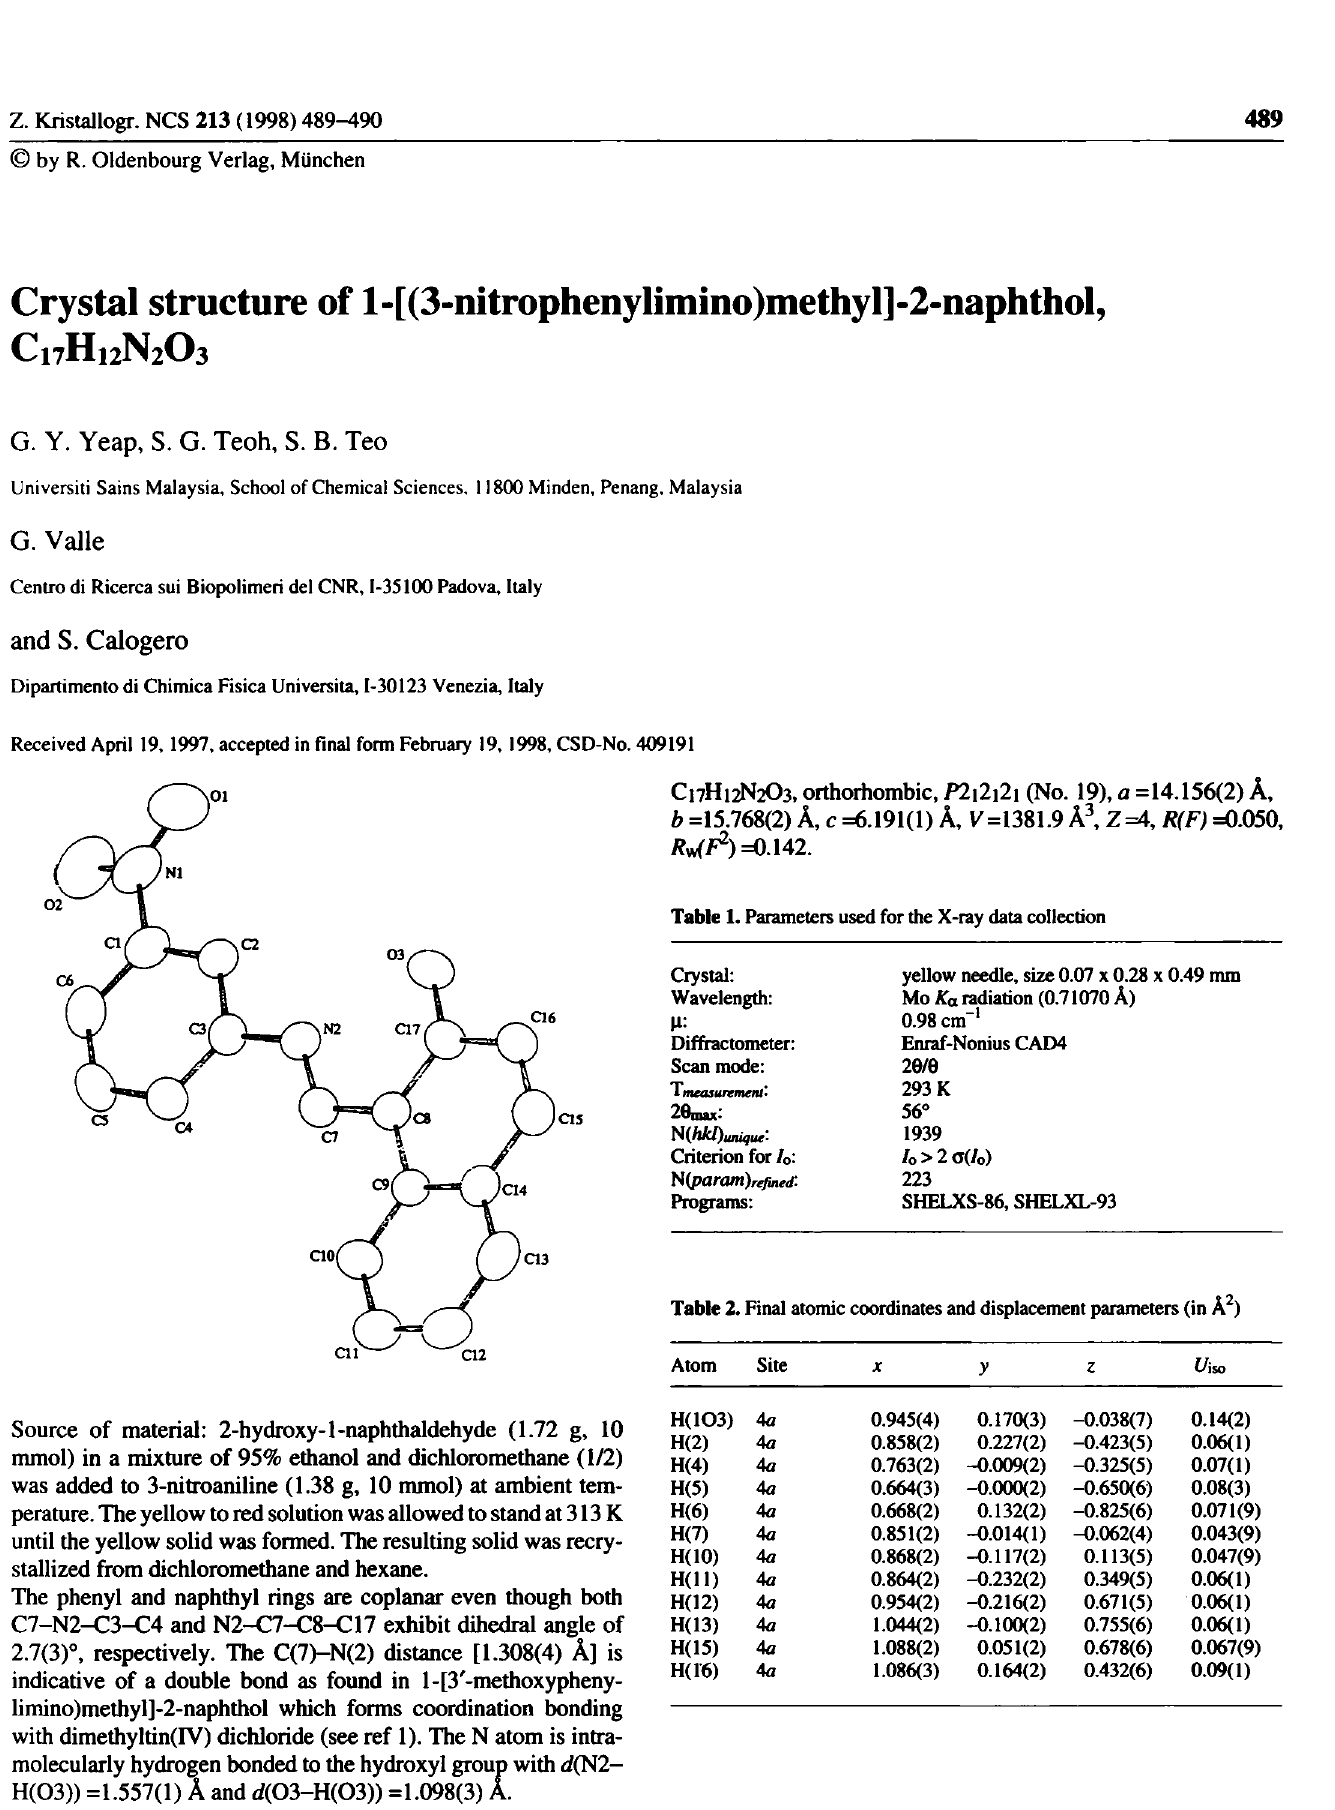
Table 1. Parameters used for the X-ray data collection